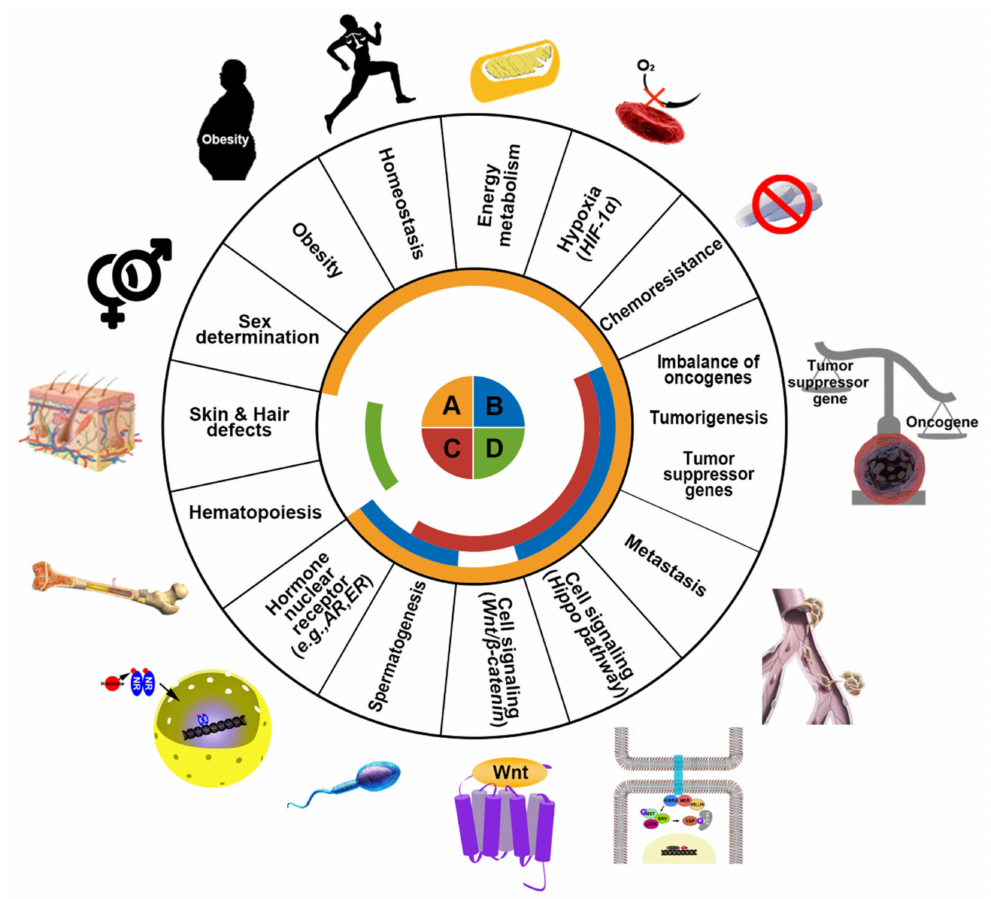
Figure 2. Schematic representation of the major functions of KDM3 in humans. The KDM3 family consists of four proteins: KDM3A (orange) KDM3B (blue) KDM3C (red) and KDM3D (green). These proteins regulate gene expression and chromatin dynamics by demethylating H3K9me1 / 2. KDM3 family proteins normally function in energy metabolism, homeostasis, obesity, sex determination, hematopoiesis, hormone nuclear receptor signaling, spermatogenesis, and cell signaling pathways. However, dysregulationinKDM3expressionorfunctionpromotesskinandhairdefectsandtumorigenic processes such as cell survival under hypoxia, malfunction of tumor suppressor genes, induction of oncogenes, development of chemoresistance, and metastasis in cancer